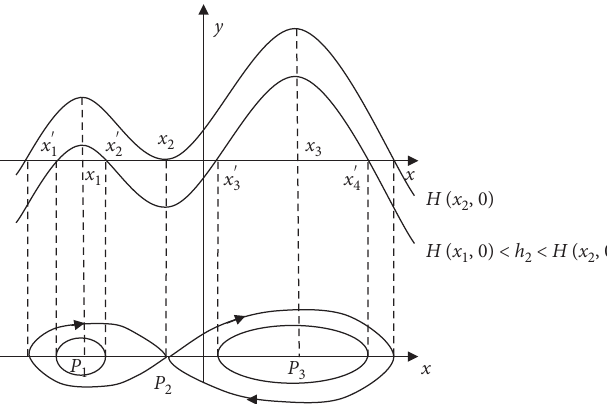
Figure 3: − F ( x ) function curve and periodic trajectories when q < 0 , Δ < h